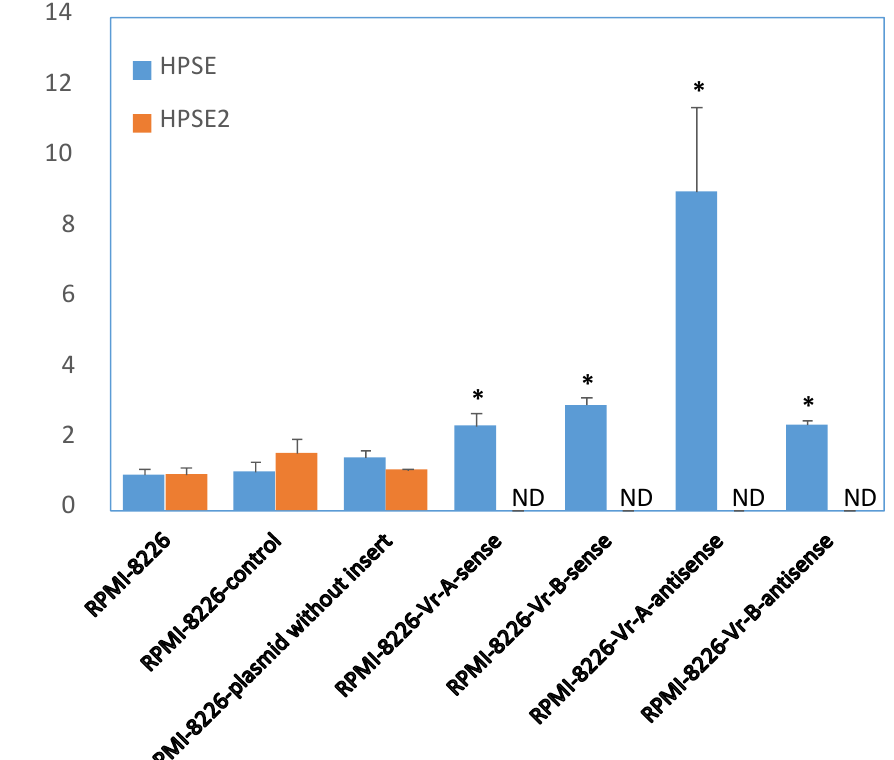
Figure 2. Expression of the HPSE and HPSE2 genes in multiple myeloma RPMI-8226 cells transfected with the HPSE gene enhancer fragment. Four HPSE enhancer constructs were inserted upstream of the luciferase gene in pGL4.26 vector with minimal promoter and transfected into RPMI-8226 myeloma cells [30]. DNA constructs were prepared in sense and antisense direction. The HPSE gene enhancer fragment (440 bp) included rs4693083, rs4693608, rs4693084, and rs4693609 SNPs. Vr-A construct contains allele A of rs4693608 and allele G of rs4693084. Vr-B fragment includes allele G of rs4693608 and allele T of rs4693084. Samples of RPMI-8226 cells before and after transfection were analyzed by quantitative RT-PCR. RQ (relative quantification) values are shown on the y-axis. HPSE gene expression levels were elevated in enhancer fragment-transfected samples compared to controls, while HPSE2 gene expression was decreased to undetectable levels in the same samples. Samples treated with AMAXA electrical pulse alone or transfected with empty plasmid were used as controls. No differences were observed between untreated and treated samples. Data shown are of representative experiments performed in triplicates. Differences in RQ among various constructs were evaluated by t-test. p value of ≤ 0.05 was regarded as statistically significant. * p value of ≤ 0.05. ND — not detected.